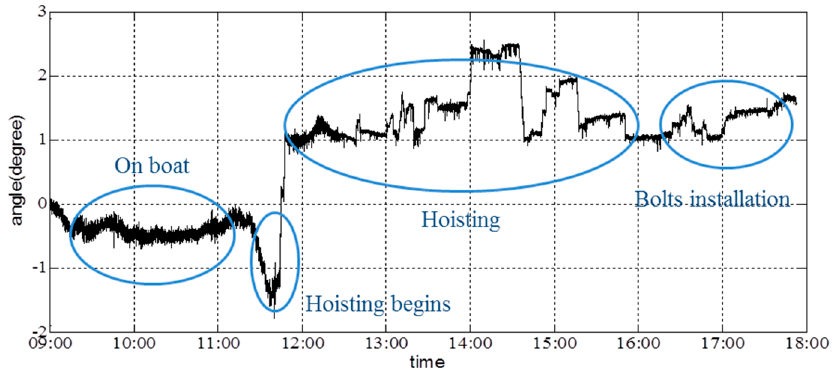
Figure 26. Angle about the x -axis of the girder.